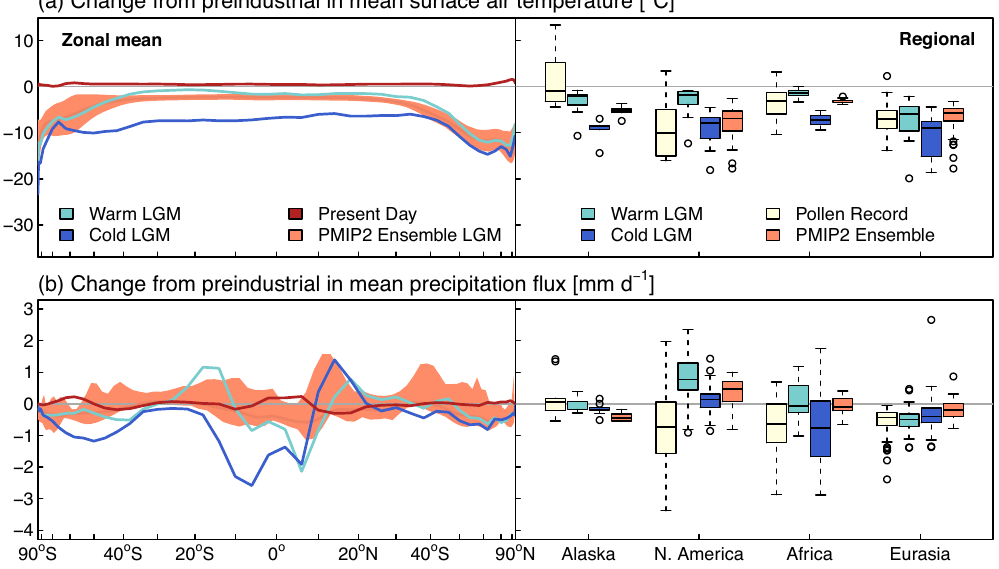
Fig. 4. Evaluation of climate changes for (a) mean surface temperature and (b) zonal mean precipitation flux. The left panels compare our ModelE simulations to the range of zonal mean changes from the preindustrial in the Paleoclimate Multimodelling Intercomparison Project Phase II (PMIP2; Braconnot et al., 2007a). The latitudinal axis is weighted by relative zonal area. The right panels compare our simulation to the pollen-based climate reconstruction from Bartlein et al. (2011) using box-and-whisker plots; dots indicate outliers. The above study used the present day as its baseline, and we follow that convention here. We sample our simulations and the PMIP2 ensemble at the locations of the sediment core measurements.